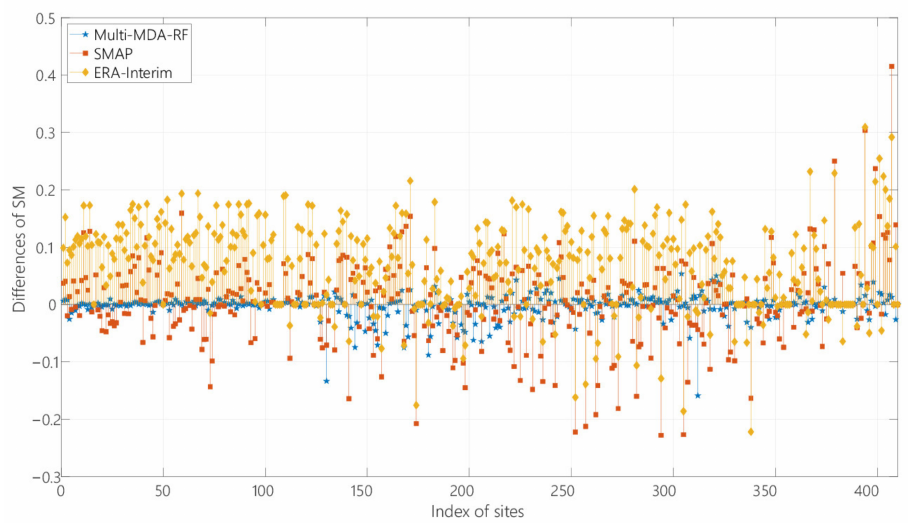
Figure 14. Difference diagram by comparing Multi-MDA-RF, SMAP, EAR-Interim with in-situ measurements.